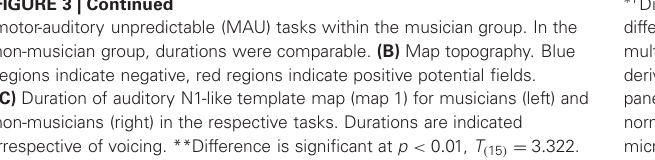
FIGURE 3 | Continued motor-auditory unpredictable (MAU) tasks within the musician group. In the non-musician group, durations were comparable. (B) Map topography. Blue regions indicate negative, red regions indicate positive potential fields. (C) Duration of auditory N1-like template map (map 1) for musicians (left) and non-musicians (right) in the respective tasks. Durations are indicated irrespective of voicing. **Difference is significant at p < 0 . 01, T ( 15 ) = 3 . 322.